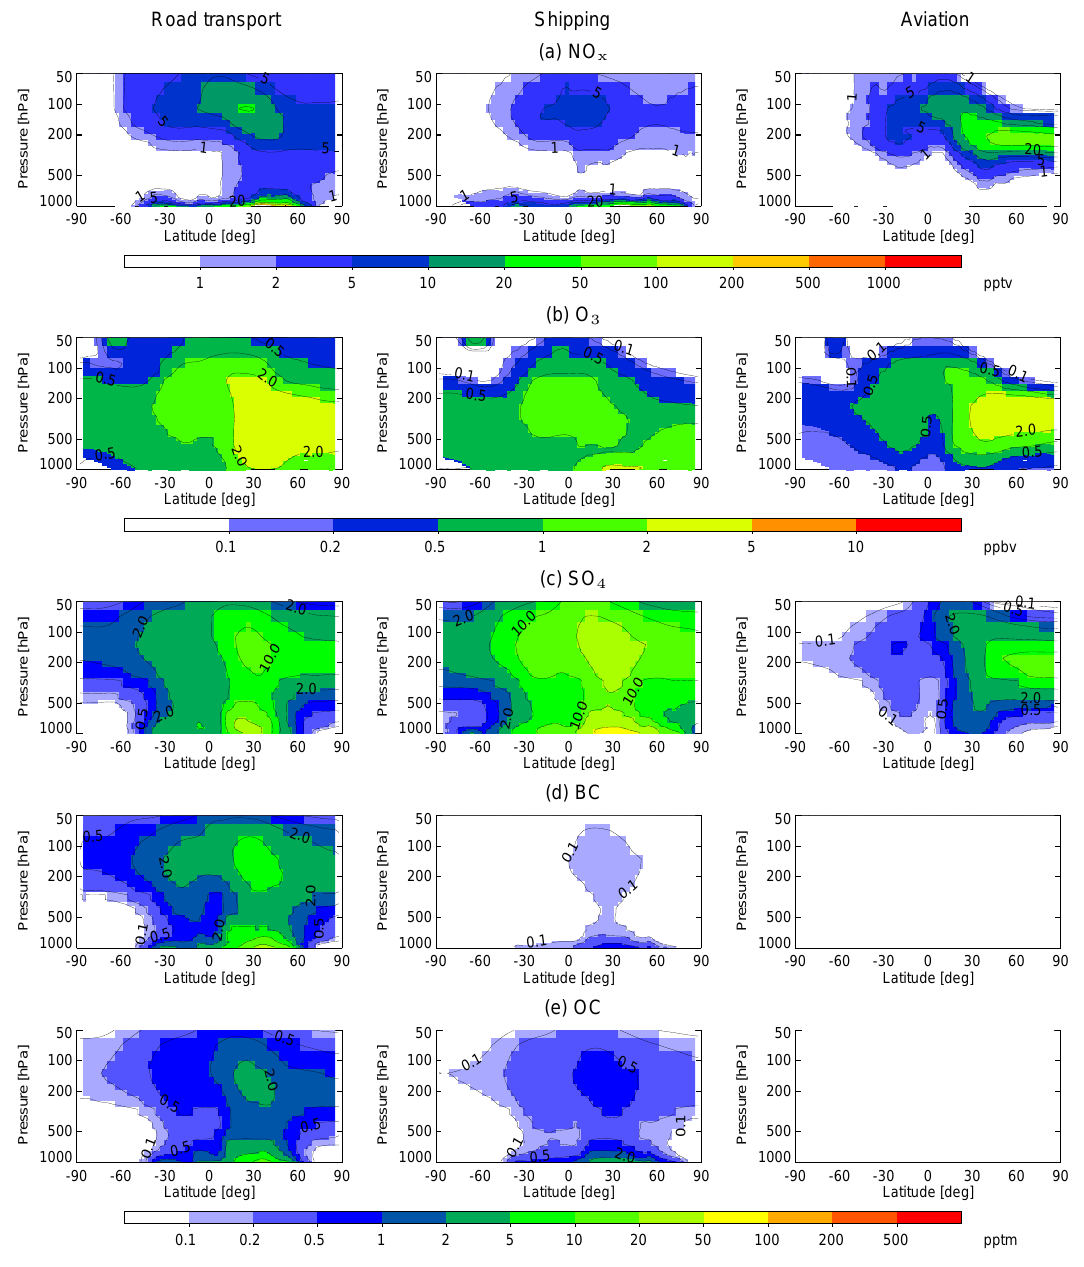
Fig. 3. Contribution by road transport (left), shipping (middle) and aviation (right) to the distribution of (a) NO x (pptv), (b) O 3 (ppbv), (c) sulfate (ppt), (d) BC (ppt), and (e) OC (ppt) in JJA 2000. These contributions are obtained by off-line CTM simulations: O 3 and NO x are averages over the p-Tomcat, LMDZ-INCA and Oslo-CTM2 models, while the aerosol fields are those of the LMDZ-AER model. aviation-induced cirrus in the regions with dense air